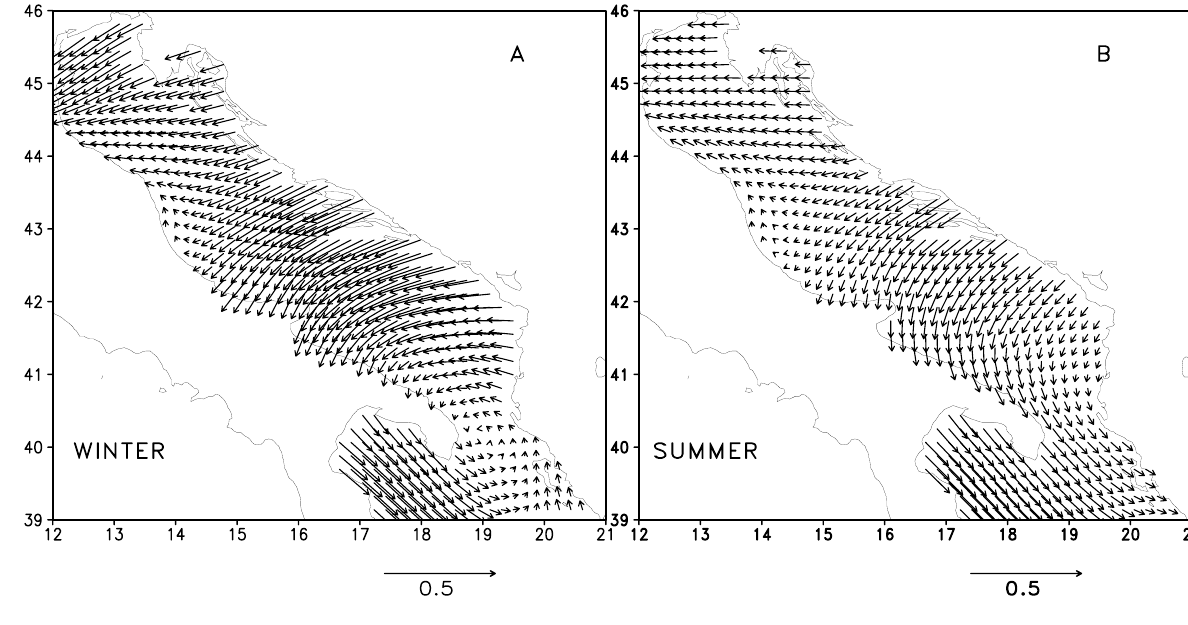
Fig. 2. Seasonal climatological wind stress distribution interpolated in the AIM grid. (A) : winter, (B) : summer. Units are dyne/cm 2 . Not all grid points have been plotted. Seasons definition as in Artegiani et al. (1997a, b).